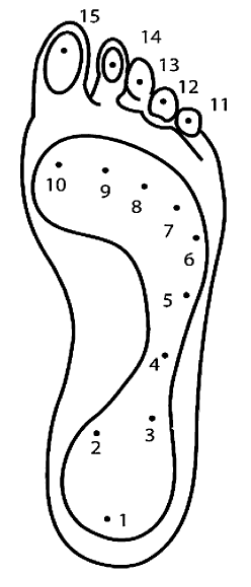
Figure 5. Foot anatomical areas